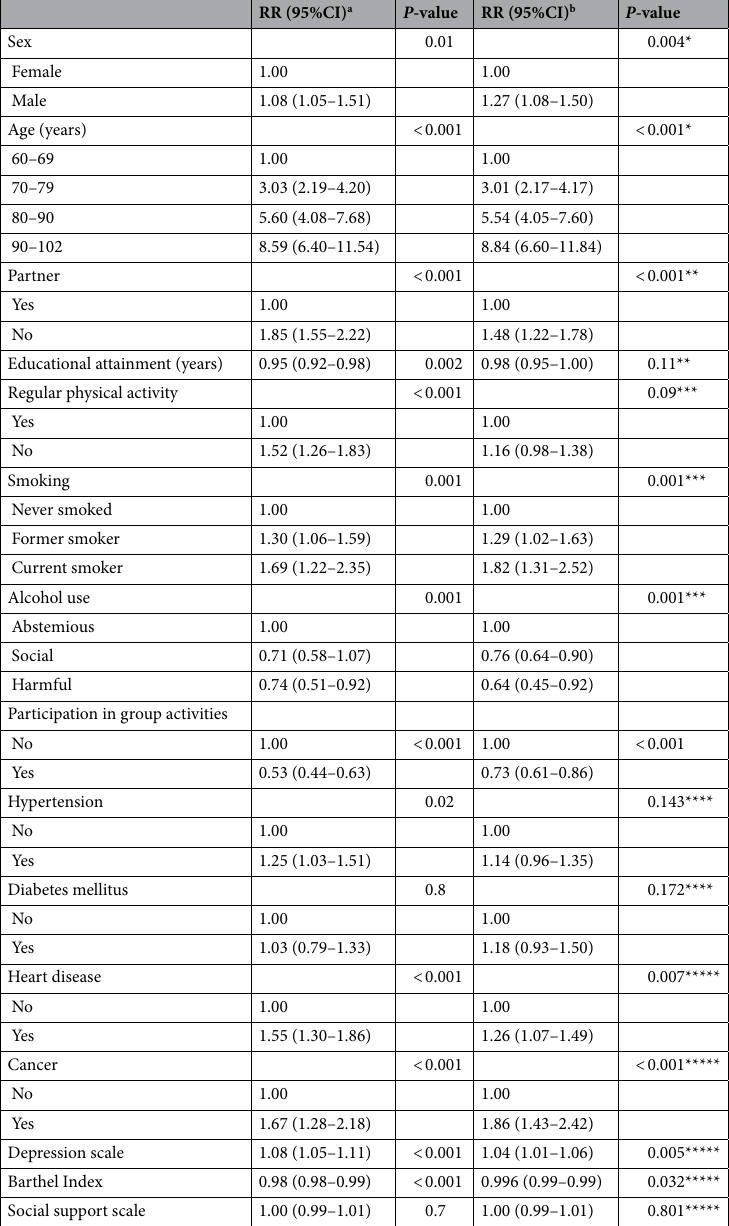
Table 2. Relative risk (95%CI) for mortality in the presence of traditional and neglected risk factors at baseline (n = 882). a Relative risk and 95%CI without controlling for confounding factors. b Relative risk and 95%CI after controlling for the following confounding factors: *Model 1: age and sex. **Model 2: model 1 + educational attainment and partner. ***Model 3: model 2 + physical activity, smoking, alcohol abuse, participation in group activities, and hypertension. ****Model 4: model 3 + history of heart disease, history of cancer, depression scale. *****Model 5: model 4 + Barthel